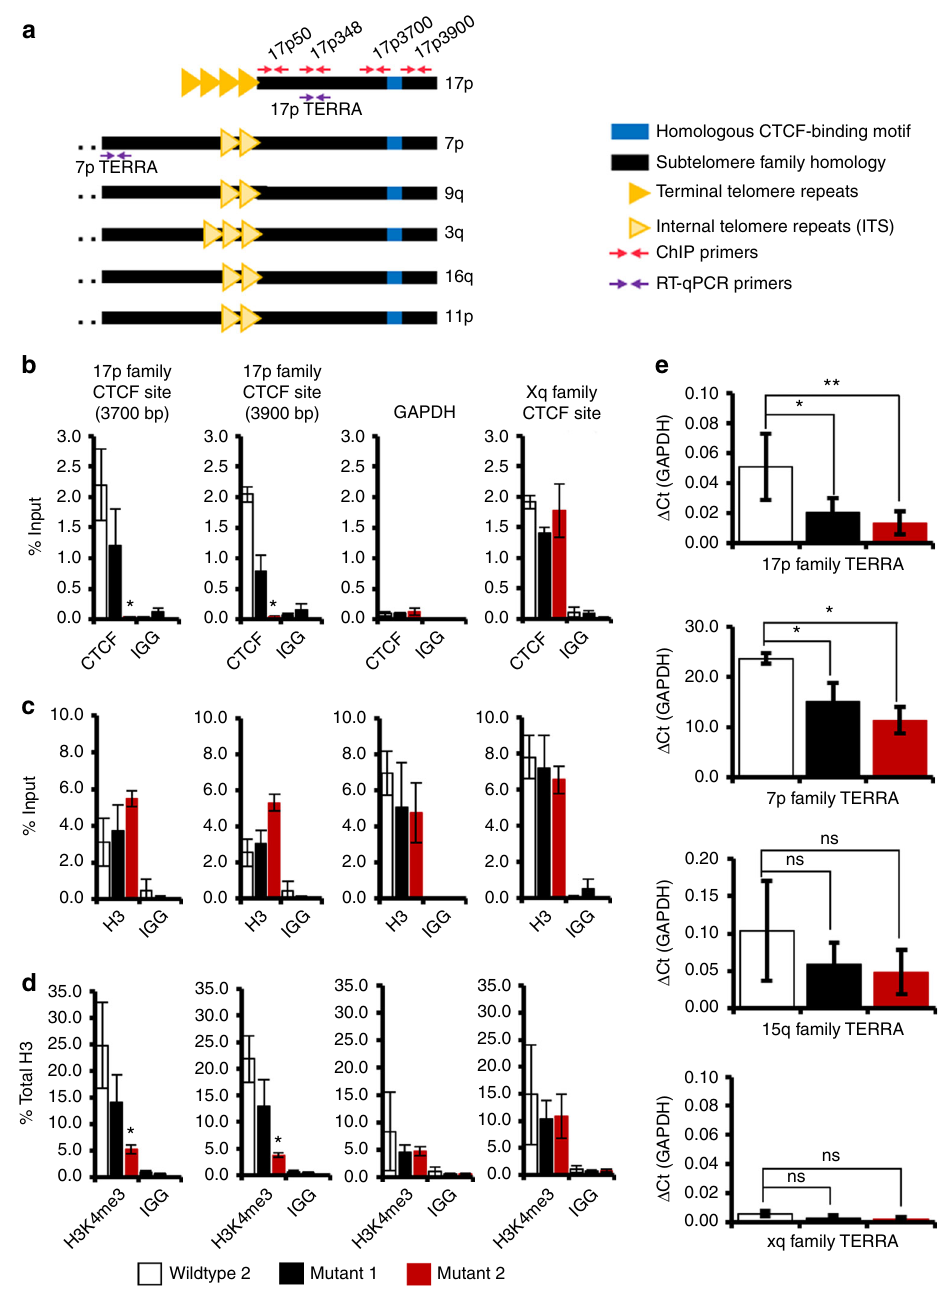
Fig. 2 CTCF site-deletion mutants exhibit local decreases of subtelomeric CTCF, H3K4me3, and TERRA transcription. a Schematic of 17p family and 7p subfamily homology with position of primers used for RT-qPCR (purple) and ChIP-qPCR (red). b Wildtype (white bar) and mutant cells (black and red bars) were collected and chromatin immunoprecipitation was performed to look at binding of CTCF; c total histone H3; d histone H3K4me3 at either 17p family CTCF sites (primer set at 3700 bp relative or at 3900 bp relative to telomere repeat tracks), GAPDH, or the Xq family of subtelomeric CTCF sites. e RNA was isolated from cell lines and analyzed by RT-qPCR to assess chromosome-speci fi c TERRA transcription levels for primers detecting all 17p family TERRA, 7p family, 15q family, or Xq family TERRA transcripts. All ChIP and RNA experiments represent 3 – 5 combined biological replicates with error bars expressing SEM of replicates. * p < 0.05; ** p < 0.01, or not signi fi cant (ns), measured by Student's t